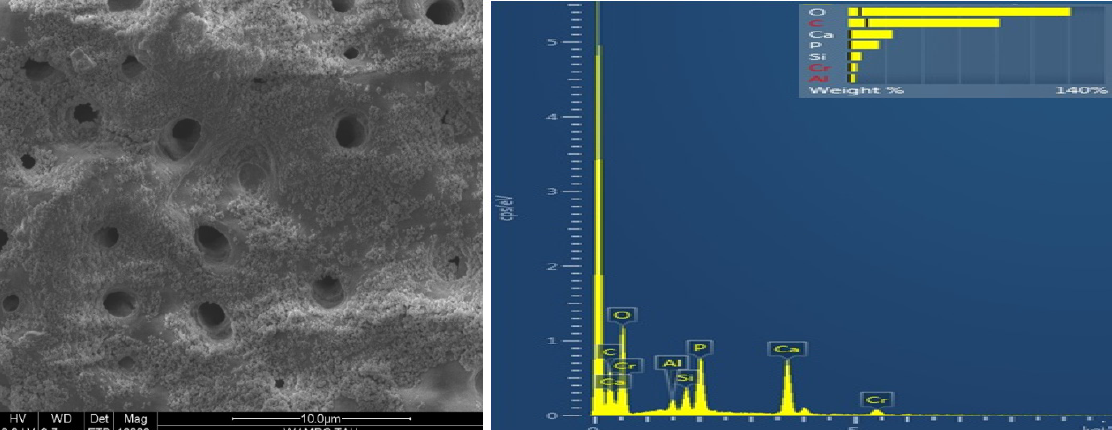
Figure 9. Microscopic image of the air-abraded and subsequently acid-etched dentin. The acid removed most of the smear layer and disclosed open dentinal tubules. The intertubular dentin is rough. EDS analysis revealed lower concentrations (wt %) of Si and Al, yielding 1.49% and 0.38%, respectively. Polymers 2022 , 14 , x FOR PEER REVIEW 12 of 14